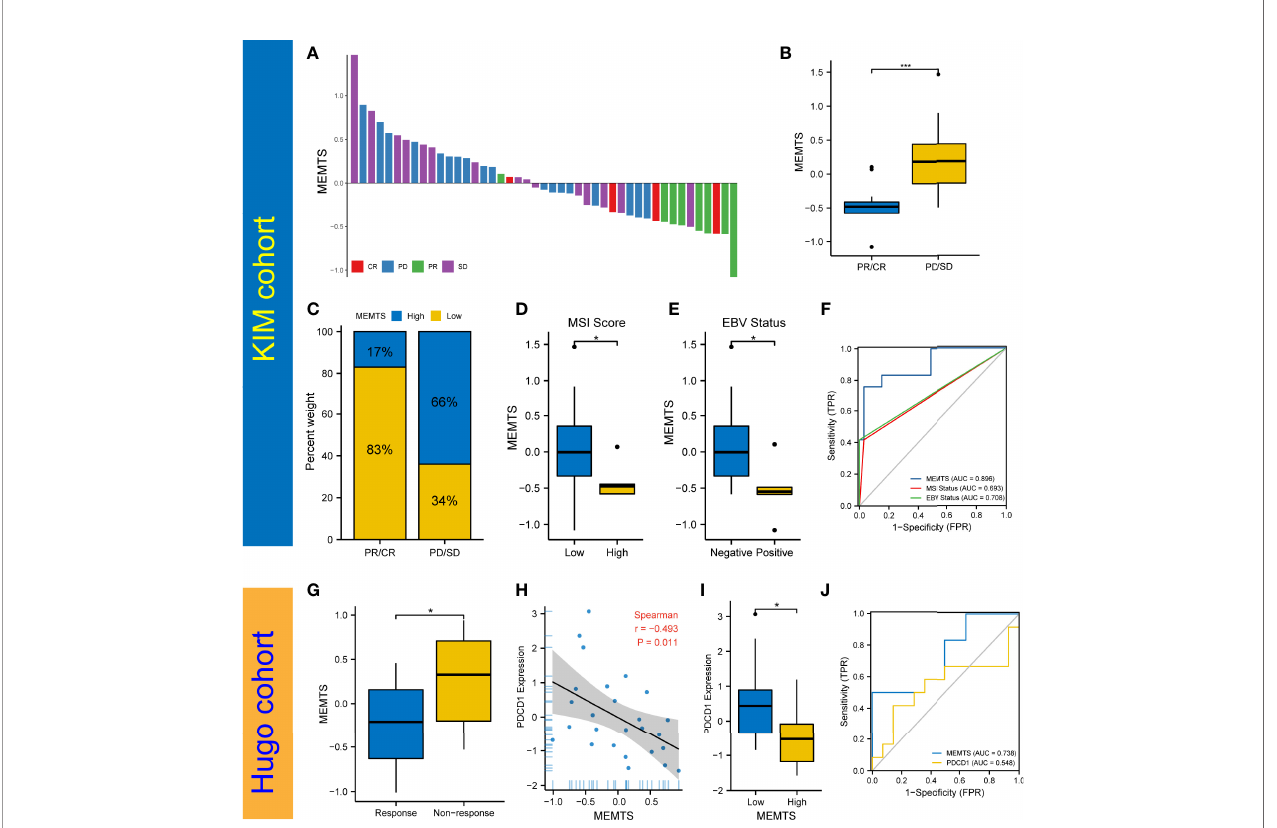
FIGURE 5 | Prediction of the response to immune checkpoint blockade treatment. (A) The correlation of MEMTS with response to immunotherapy in KIM cohort. CR, complete response; PD, progressive disease; PR, partial response; SD, stable disease. (B) Difference in MEMTS between PR/CR group and PD/SD group (***P < 0.001, Wilcoxon test). (C) The proportion of patients with different response to immunotherapy in two MEMTS subtypes. (D) Difference in MEMTS between low group and high MSI score group (*P < 0.05, Wilcoxon test). (E) Difference in MEMTS between negative and positive EBV status (*P < 0.05, Wilcoxon test). (F) The predictive value of MEMTS, MSI status and EBV status in patients treated with immunotherapy (AUC of MEMTS, 0.896; AUC of MSI status, 0.693; AUC of EBV status, 0.708). (G) boxplot showing patients with no response to immunotherapy had the higher MEMTS than patients with response to immunotherapy (*P < 0.05, Wilcoxon test). (H) Spearman analysis of correlation between MEMTS and PDCD1 expression in Hugo cohort (r = -0.493, P = 0.011). (I) Difference in PDCD1 expression between low and high MEMTS subtypes in Hugo cohort (*P < 0.05, Wilcoxon test). (J) The predictive value of MEMTS, PDCD1 in Hugo cohort (AUC of MEMTS, 0.738; AUC of PDCD1,